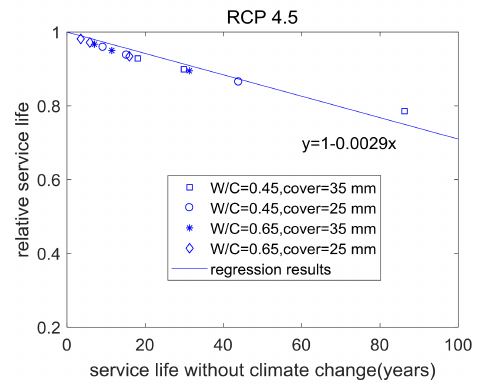
Figure 15. Relative service life of cracked concrete-RCP 4.5, time slice